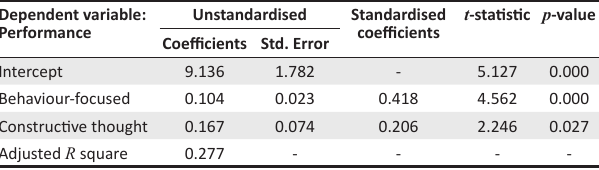
TABLE 6: Regression results (both locus of control and self-leadership). Dependent variable: Unstandardised Performance